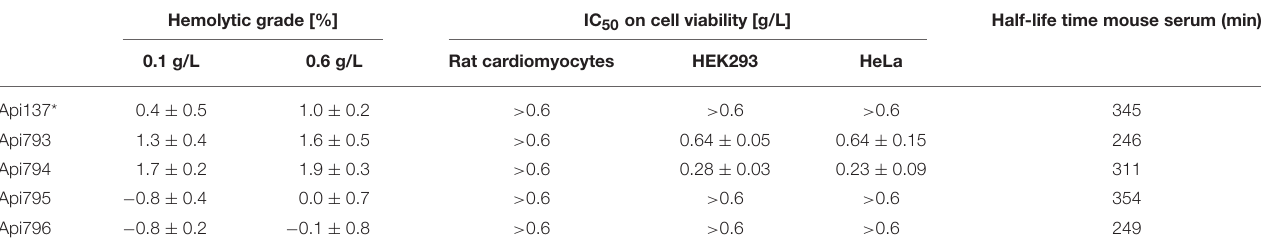
TABLE 2 | Hemolytic grades against human erythrocytes, cytotoxicity (IC 50 ) against rat cardiomyocytes, HEK293 cells, and HeLa cells, and half-life times in mouse serum determined for Api137 and the four new apidaecin analogs. Hemolytic grade [%] IC 50 on cell viability [g/L] Half-life time mouse serum (min)